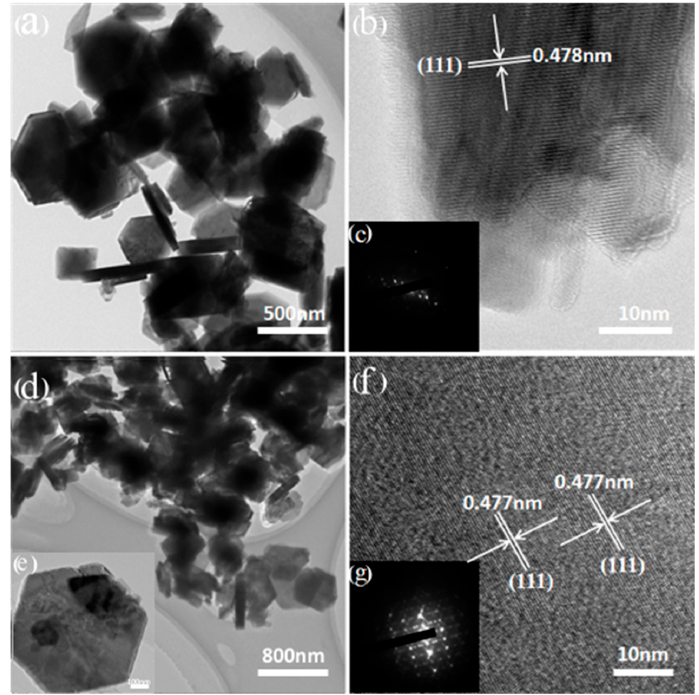
Figure 7. high resolution transmission electron microscopy (HRTEM) images and selected area electron diffraction (SAED) patterns of the LMO ( a – c ) and HMO ( d – g ).